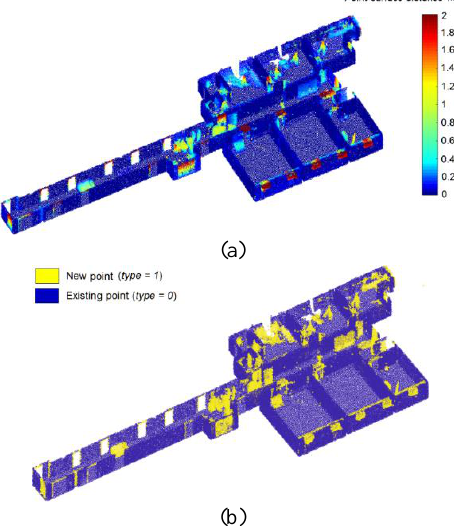
Figure 6. Comparison results of the TUB1 dataset: (a) the point cloud colorized according to point-surface distances; (b) the point cloud with the result of point classification.